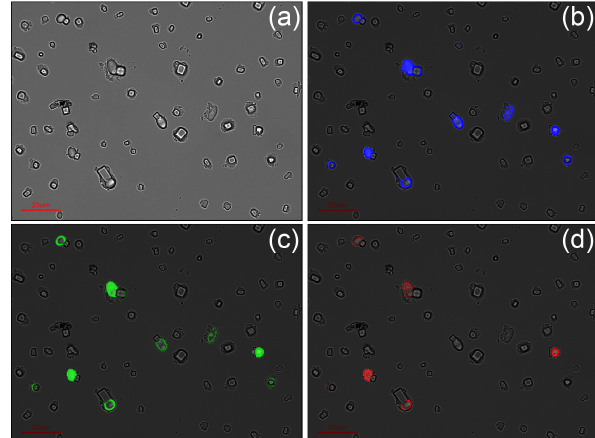
Figure 8. Fluorescence microscopy images of ambient aerosols collected on MOUDI stage 5 (size range, D 1.0–1.8µm) on 25 August, 03:00–07:00 (LT). Illumination source: (a) bright field; (b) λ ex = 340–380nm, λ em = 435–485; (c) λ ex = 465–495nm, λ em = 510–560; and (d) λ ex = 540–580nm, λ em = 600–660. Mag- nification ×